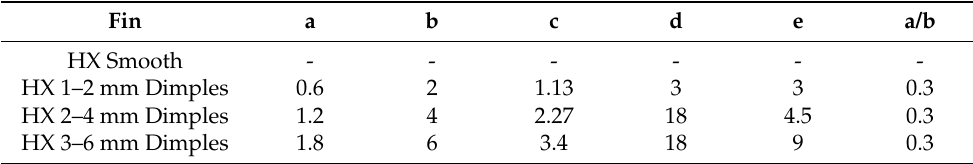
Table 3. Geometric configuration of HX samples.